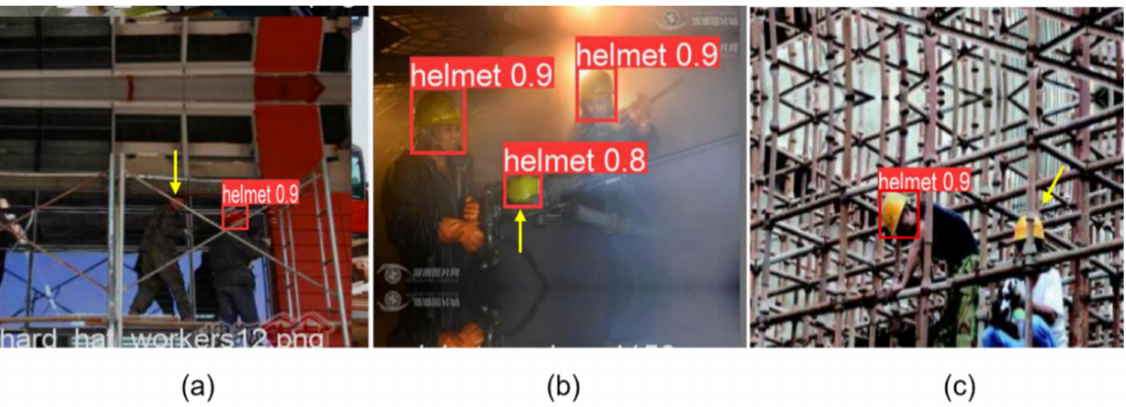
Figure 11. Detection Errors by the YOLOv5x model. ( a , c ) Helmet with Obstacle, ( b ) Object Similar like